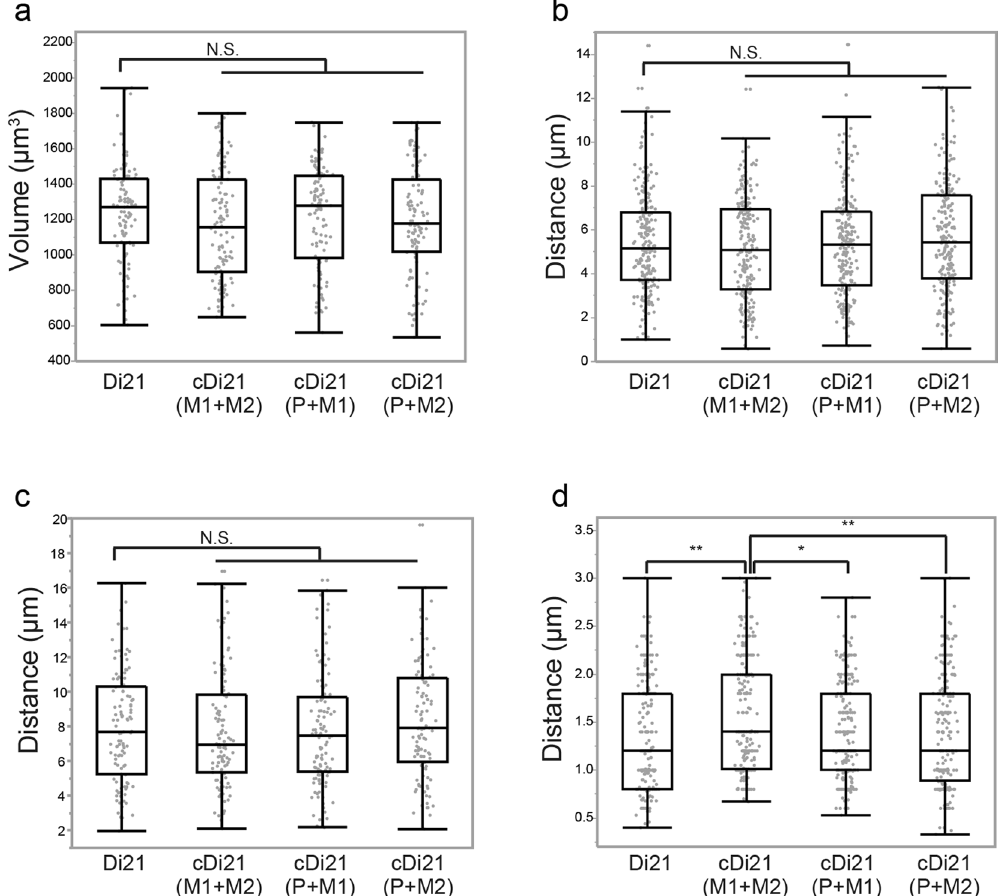
Figure 3. Positioning of chromosome 21 in Di21 and cDi21 iPSCs. ( a–d ) Chromosomal localisation in each hiPSC line [Di21, n = 110; cDi21(M1 + M2), n = 110; cDi21(P + M1), n = 116; cDi21(P + M2), n = 108]. Measurements included ( a ) the nuclear volume, ( b ) the distance from the nuclear centre to each copy of chromosome 21, ( c ) the distance between two copies of chromosome 21 and ( d ) the distance from chromosome 21 to the nearest nuclear membrane. Box plot represents 25th–75th percentile range ± min–max. p values were determined by the Mann–Whitney U test. * p < 0.05, ** p <